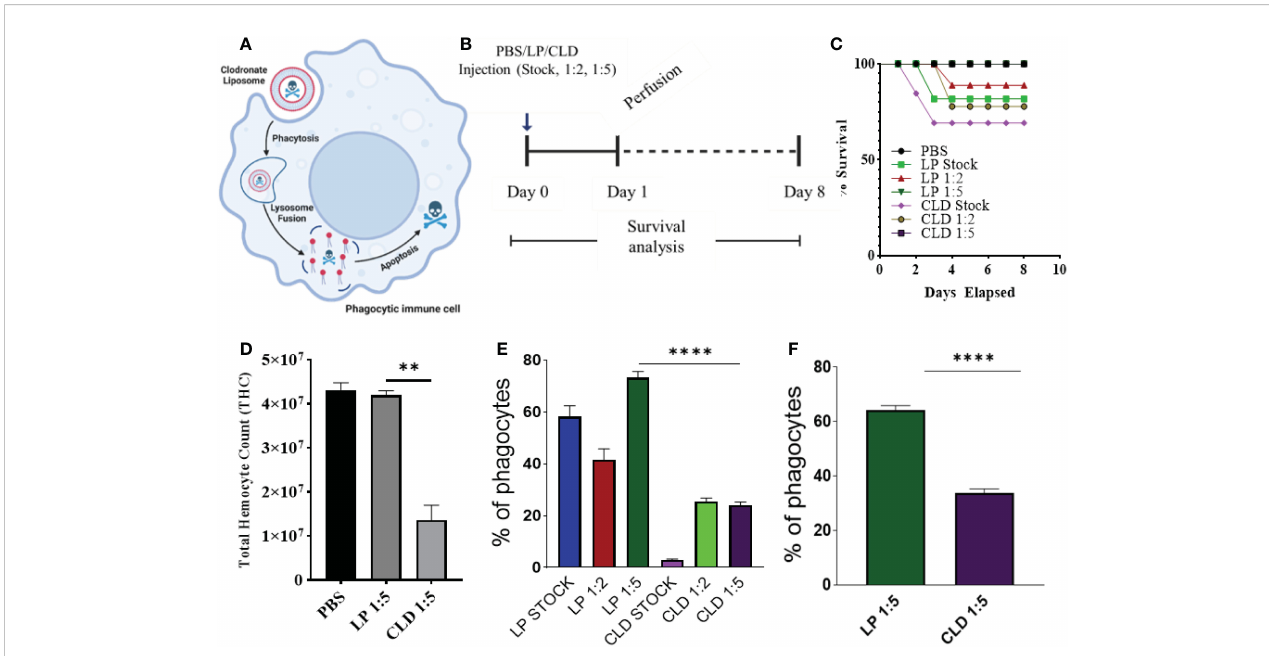
FIGURE 2 Clodronate depletion of phagocytic tick hemocytes and validation of phagocyte depletion. Mechanism of clodronate liposome-induced depletion of professional phagocytes (A) . Schematic showing the optimization of clodronate and liposome concentrations to deplete phagocytic hemocytes (B) . Tick survival was evaluated following injection of clodronate (CLD) and control liposomes (LP) at different concentrations (stock, 1:2, 1:5 in 1X PBS), with 1X PBS used as control (C) . Hemolymph was perfused 24 h post-CLD or LP injection (unfed status) to assess the effect of depletion on total hemocyte count (D) and proportion of phagocytic hemocytes (E) . The proportion of phagocytic hemocytes was also assessed in CLD- or LP-injected ticks 5-days post feeding (F) . Survival was checked each day for 8 days; 15 ticks were assigned to each treatment group. Signi fi cance was determined with the log- rank (Mantel-Cox) test using GraphPad Prism v8.4.1. Error bars represent ± SEM of fi ve ticks. Ticks from PBS, LP 1:5 and CLD 1:5 injected groups all survived throughout the observation period. Quantitative data were analyzed using unpaired t- tests in GraphPad Prism v8.4.1. **P < 0.01, ****P <